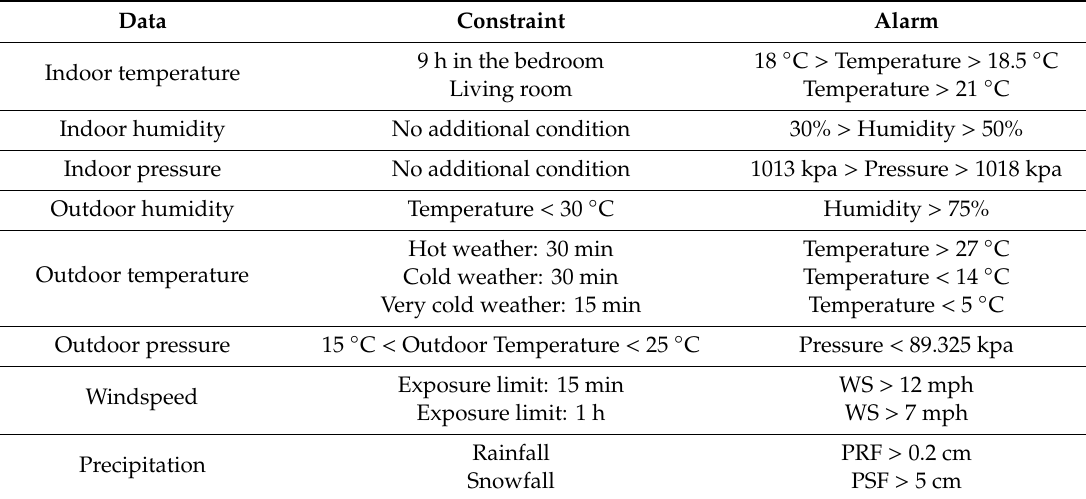
Table 12. Weather alarms and constraints for a specific profile.